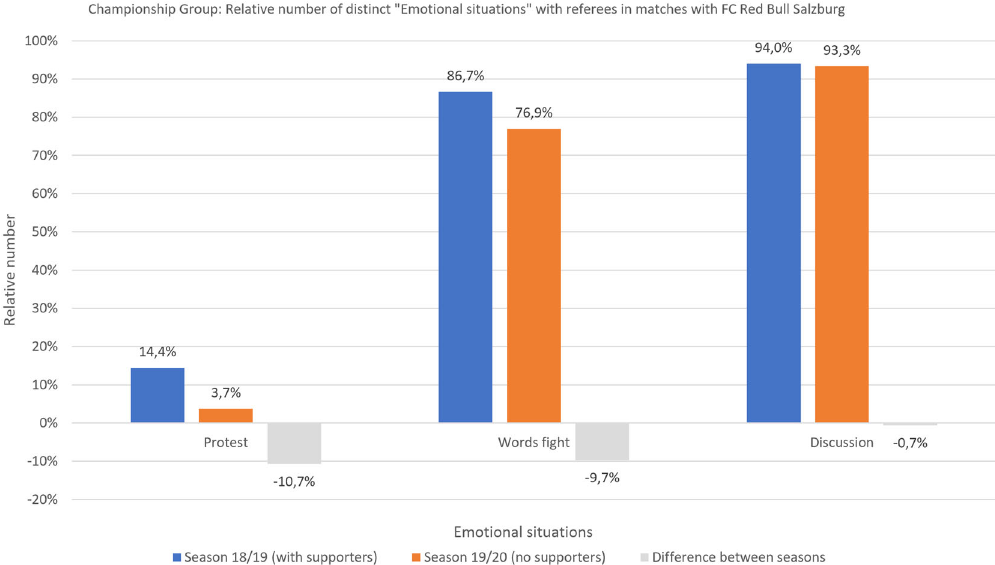
Fig. 5 Relative number of “ Emotional situations ” with referees. Differences in the relative number of distinct emotional behavior with of fi cials involved in matches with FC Red Bull Salzburg (RBS) during the championship group phase in both seasons of 2018/19 and 2019/20. Video documentation and analysis is based on our developed “ Analysis System for Emotional Behavior in Football ” (ASEB-F) (see above for details). Data shows that the relative number of emotional behavior “ Protest ” , “ Words fi ght ” and “ Discussion ” decreased in “ ghost games ” . Thus, results indicate that of fi cials acted less emotionally on players and staff behavior in “ ghost games ” than in regular games with supporters.